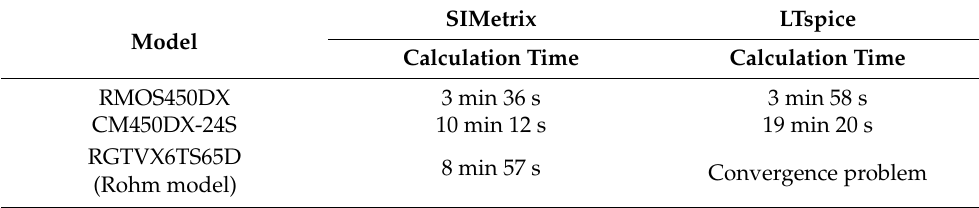
Figure 24. Photo and 3D model of UQM Powerphase 100 setup.